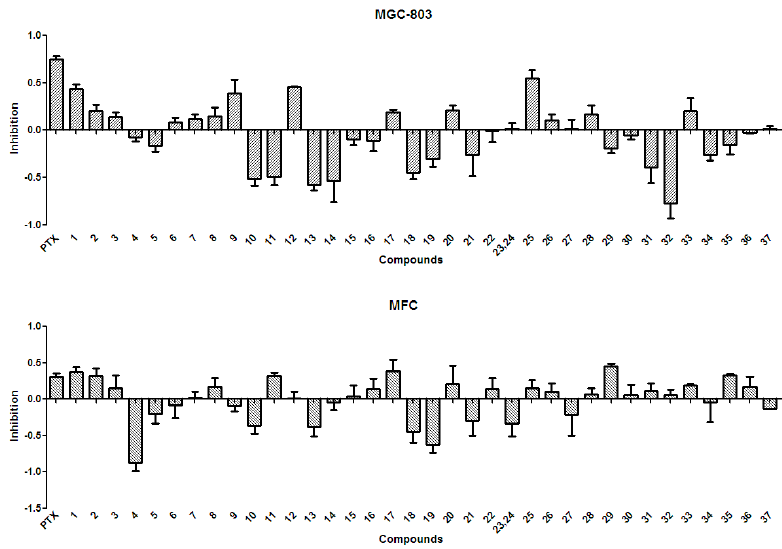
Figure 4. The anti-tumor activity against MGC-803 and MFC of the polyphenols ( 1 – 37 ) isolated from X. sorbifolia husks. MTT 3-(4,5-dimethyl-2-thiazolyl)-2,5-diphenyltetrazolium bromide was dissolved in PBS at 5 mg/mL. After the formazans were dissolved in DMSO for 10 min, the absorbance values at 490 nm were measured, and the percentage inhibitions were calculated. PTX, Paclitaxel.